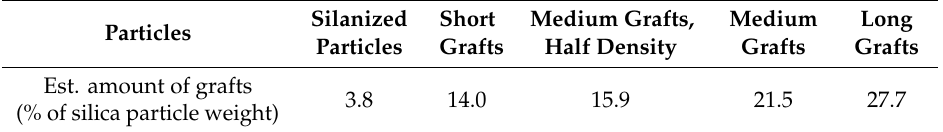
Figure 3. Result from the TGA experiments. Weight is plotted as a function of temperature for untreated silica, silanised silica and di ff erent types of grafted silica nanoparticles (short, medium, and long grafts). Table 2. Weight of the grafted polymers as estimated from TGA